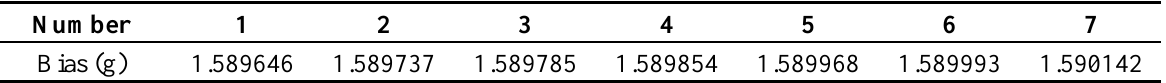
Table 6. The bias values of seven measurements for seven